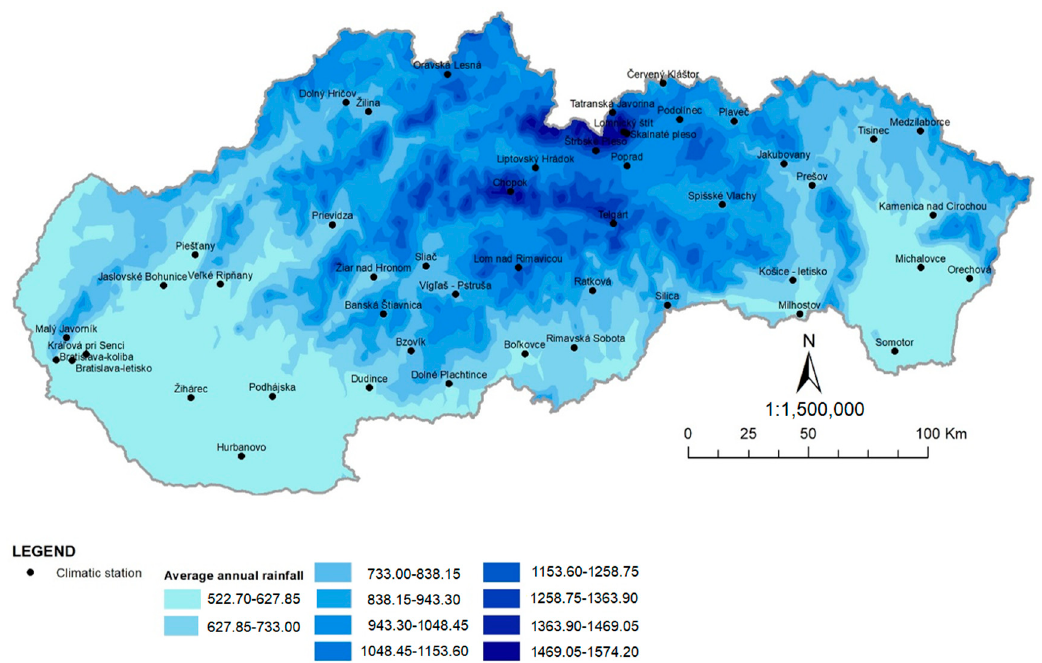
Figure 4. Average annual precipitation in Slovakia using CoKriging method.